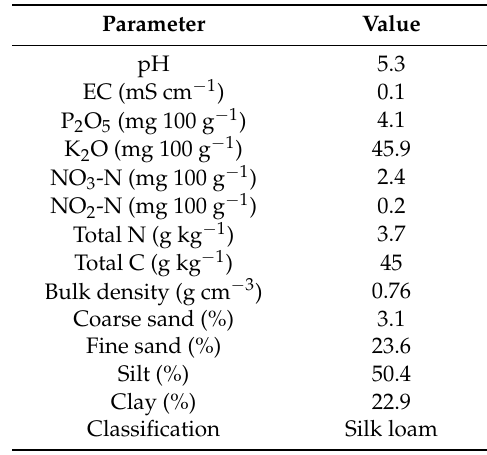
Table 1. Soil properties collected from an upland field at the Horticultural Reserarch Institute, Agricultural Research Center, Ibaraki,